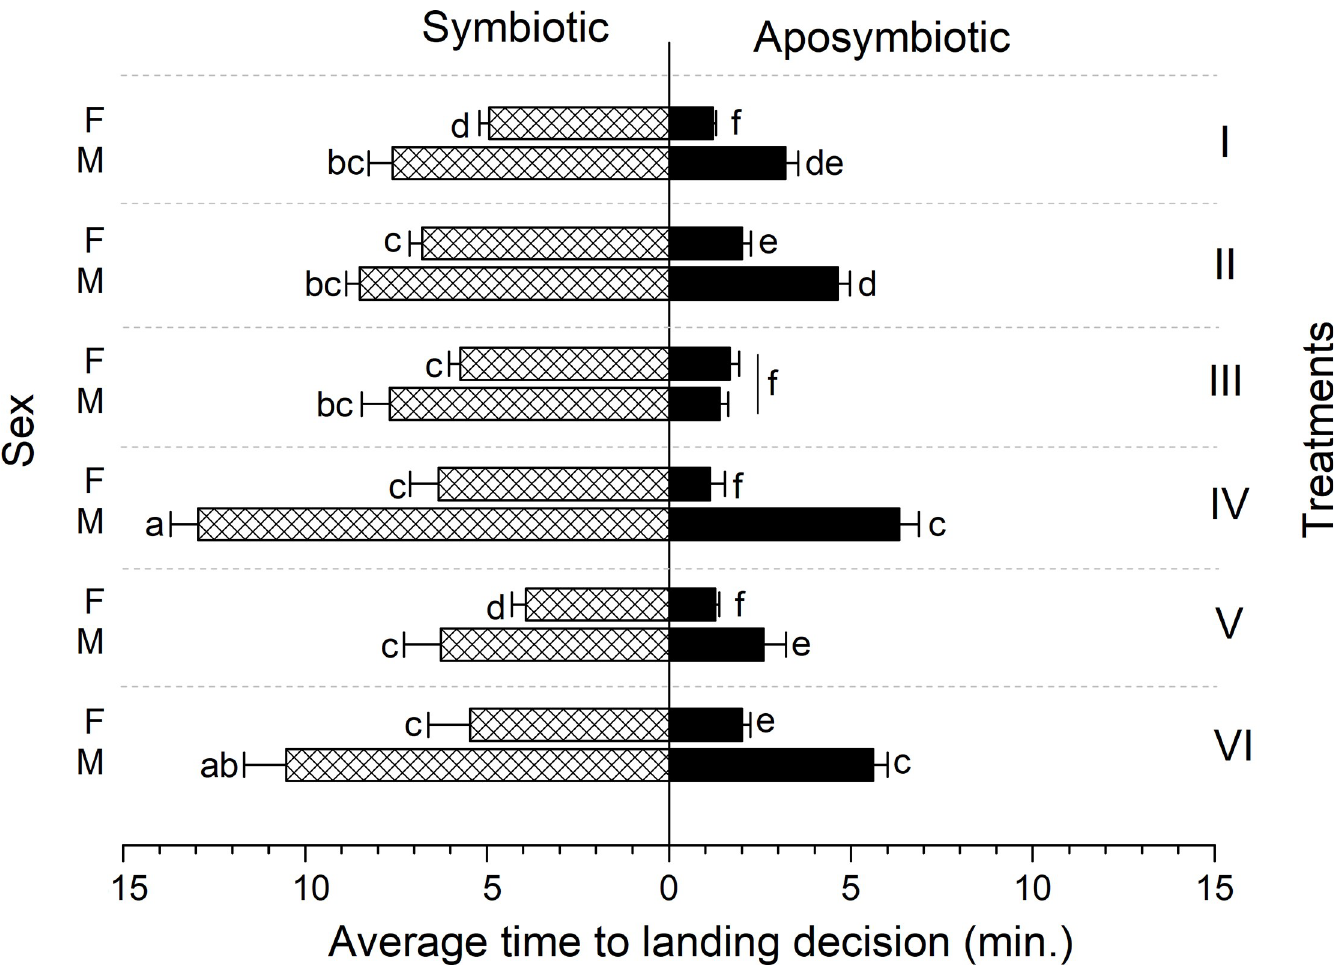
Fig 3. Response parameters of Bactrocera dorsalis males to experimental diets as affected by the symbiotic status, sex and treatments. Each latency datum is presented as a Mean ± SE of the overall latency of responded flies in each treatment.